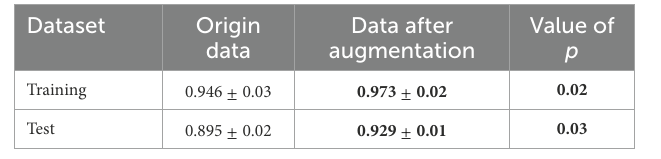
TABLE 2 Dice coefficients of segmentation models in the training and test